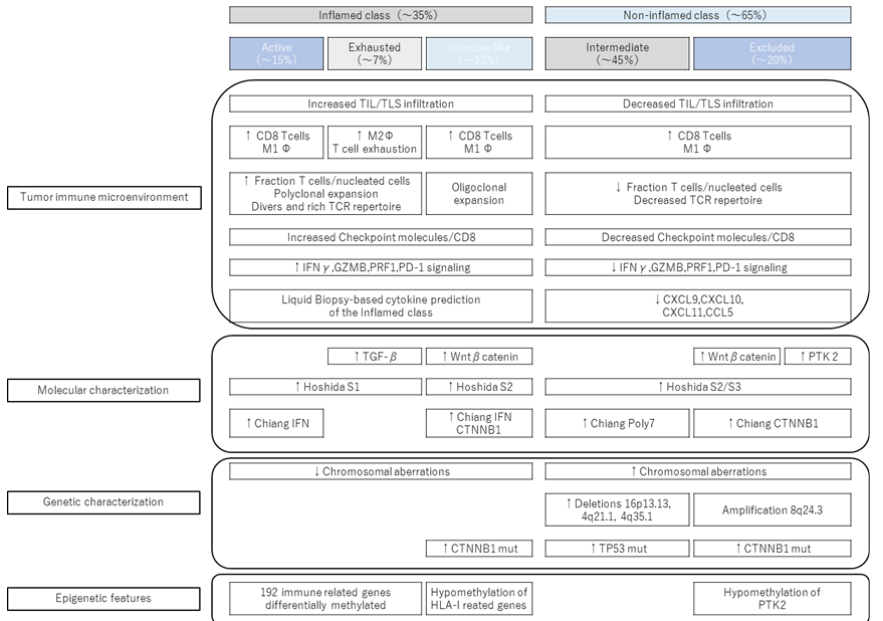
Figure 1. New immune subclass (modified quotation from [17]). A new immune-like subclass was proposed as a subclass of the inflamed class. While having similar immunological characteristics to the immune active/immune exhausted subclass, there are differences in molecular characteristics.